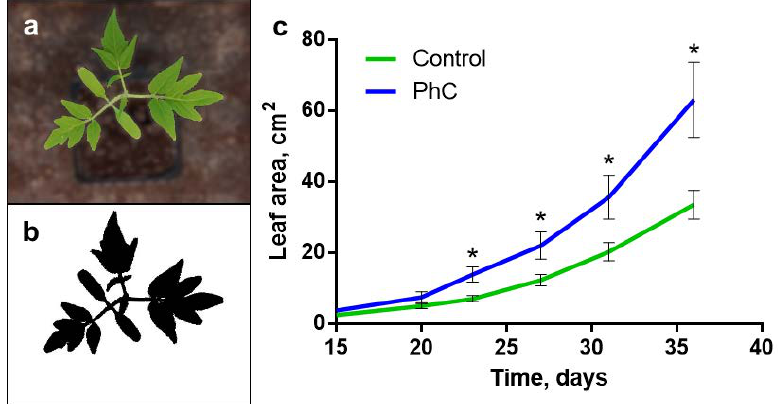
Figure 2. Influence of photoconversion coatings on the leaf area of tomato plants: ( a,b ) a photograph of a control tomato plant and a “mask” for calculating the leaf area using the ImageJ macro; ( c ) dynamics of changes in the leaf area of control plants and plants grown using the photoconversion coating (PhC). *: p < 0.05.